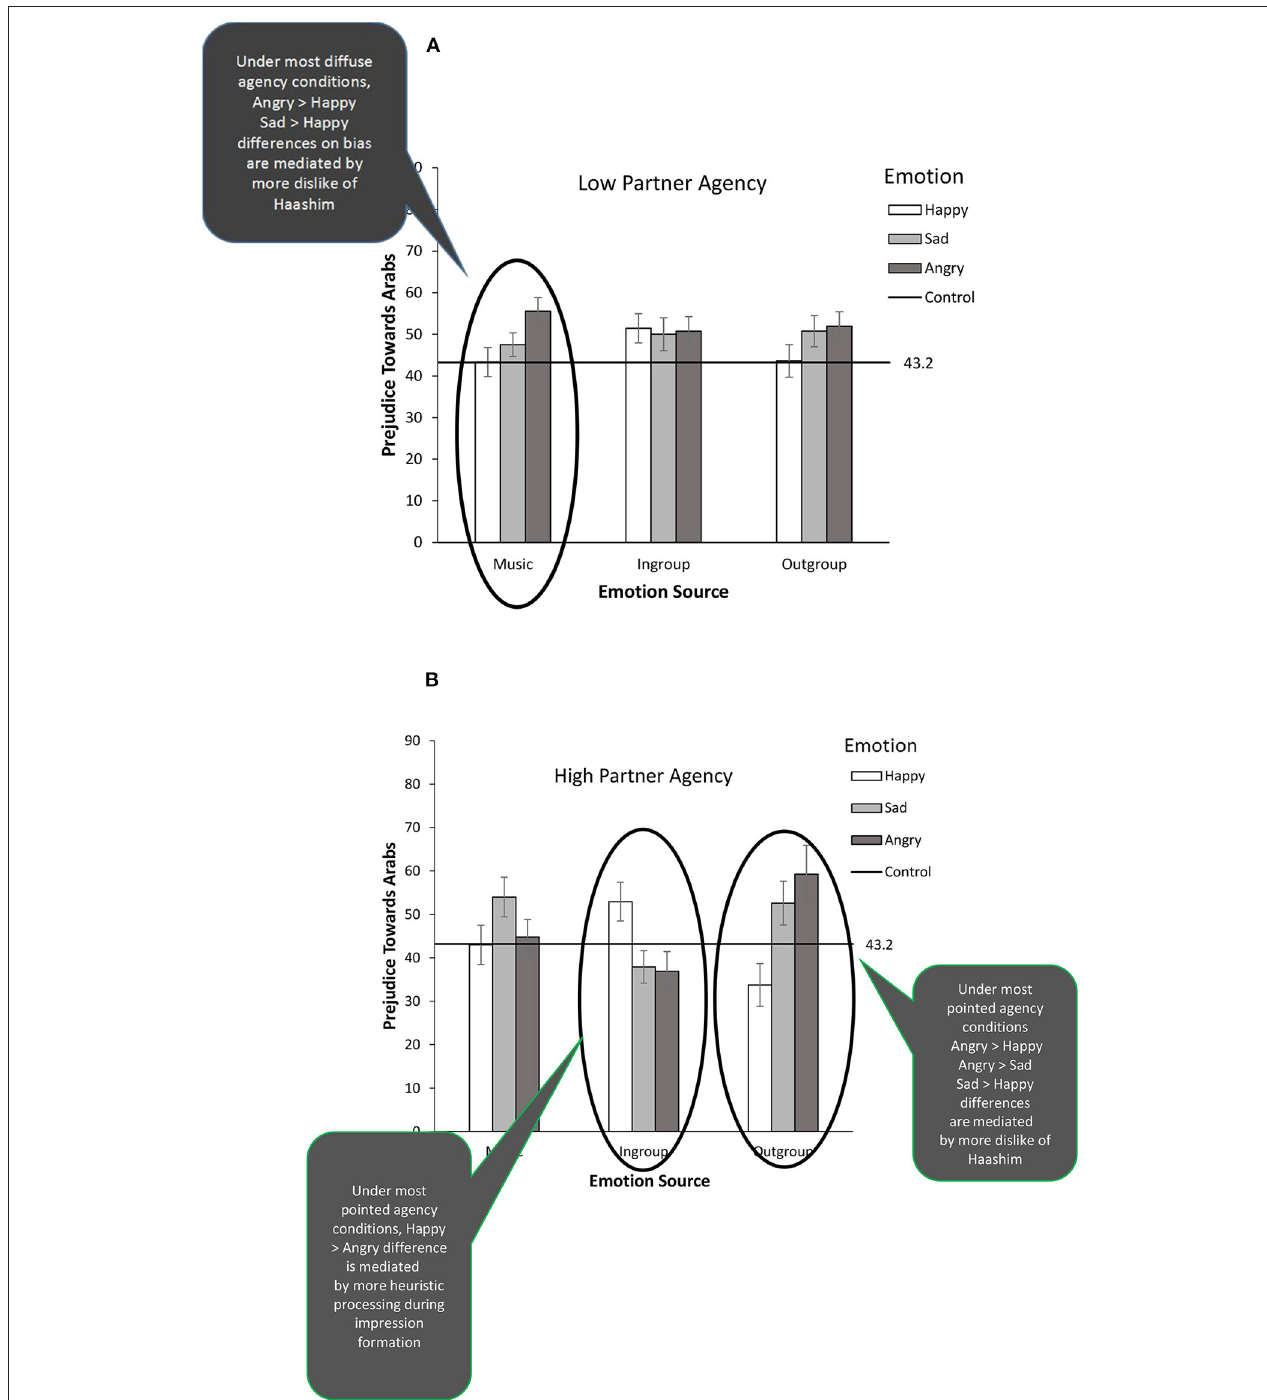
FIGURE 5 | Anti-Arab bias as a function of perceived contact partners’ agency, emotion source, and emotion (Experiment 2; N = 492 White male Americans engaged in elaborate intergroup imagery with another White American and an Arab American). Error bars represent standard errors and horizontal line bias by baseline control participants not engaging in the intergroup imagery. Significant effects of manipulated emotion are circled and significant mediational results for these effects summarized in associated word balloons.